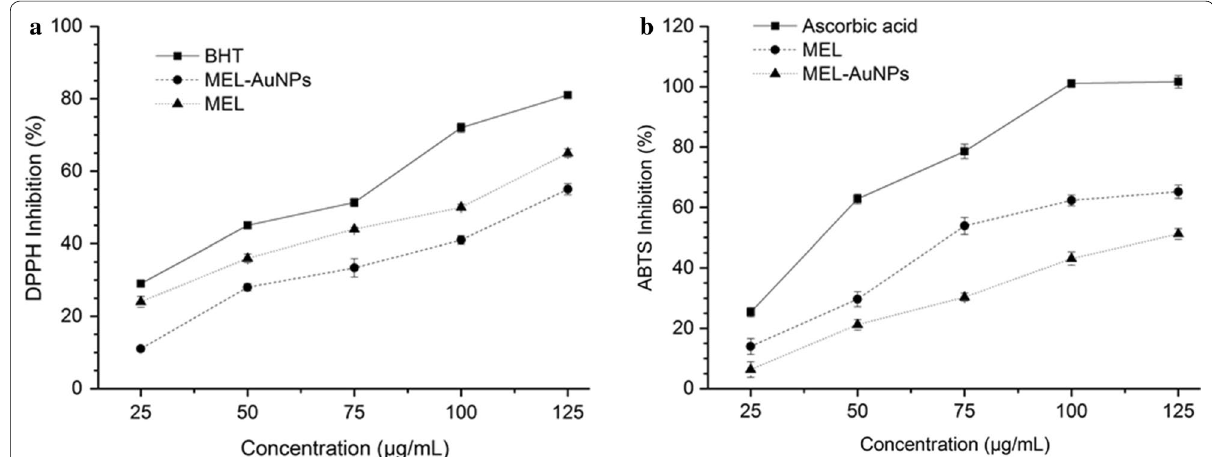
Fig. 7 Antioxidant potential of the biosynthesized MEL-AuNPs by use of DPPH and ABTS scavenging